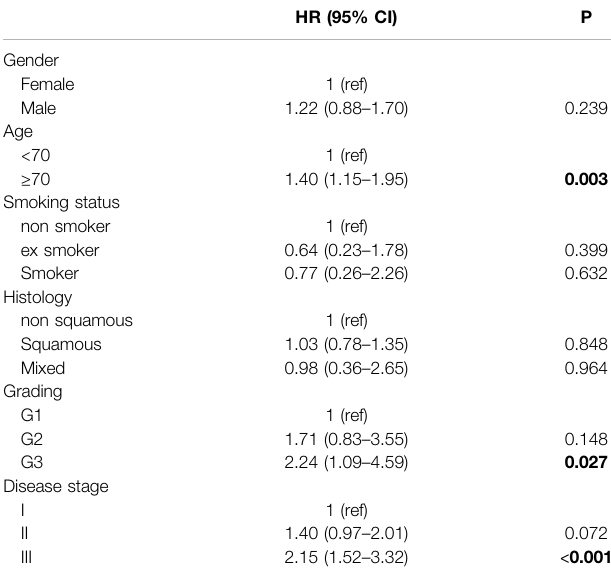
TABLE 4 | Results from univariate Cox models for demographic and clinico- pathological variables.